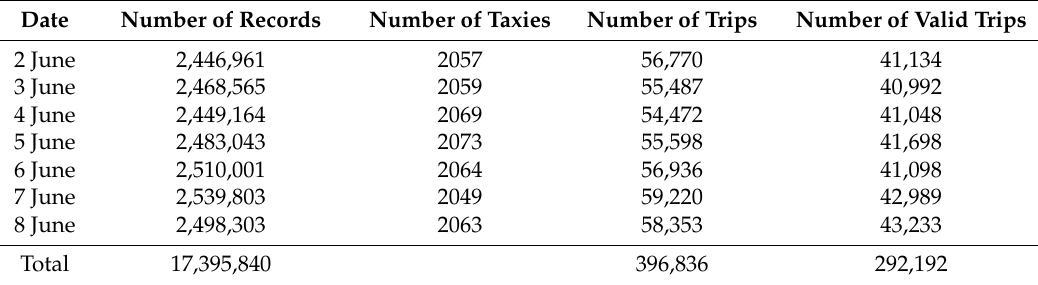
Table 2. Statistics of seven-day’s taxi records from 2 to 8 June